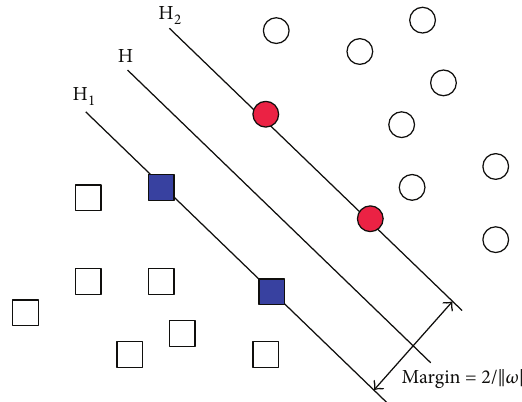
Figure 1: An example of the SVM optimal classification